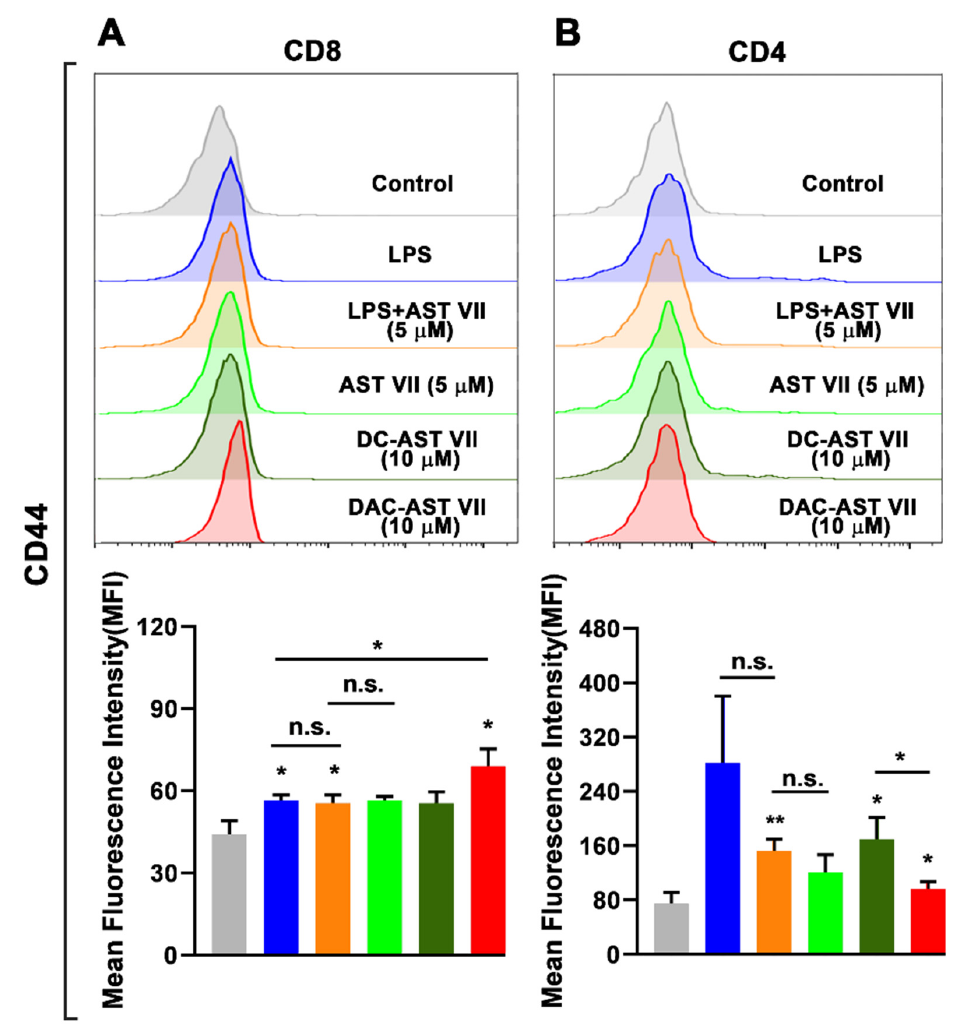
Figure 7. AST VII and its derivatives (DC-AST VII and DAC-AST VII) activated T cells in MLR. BMDCs derived from BALB/c mice were treated with LPS, AST VII, DC-AST VII, or DAC-AST VII for 24 h. The next day, BMDCs were co-cultured with naive CD4 + and CD8 + T cells isolated from the spleens of C57BL/6 mice for 3 days. The expression of CD44 on ( A ) CD8 + T cells and on ( B ) CD4 + T cells was determined using flow cytometry. Representative histograms (top panel) and summary graphs (bottom panel) are shown. Data are shown as the mean and SD of triplicates and represent three independent experiments with similar results. Statistically significant differences in the treated group were analyzed compared to the control (untreated cells). Intragroup and intergroup comparisons were performed using one-way ANOVA and Tukey’s multiple comparison test. * p < 0.05, ** p ≤ 0.01, n.s. (not statistically significant).